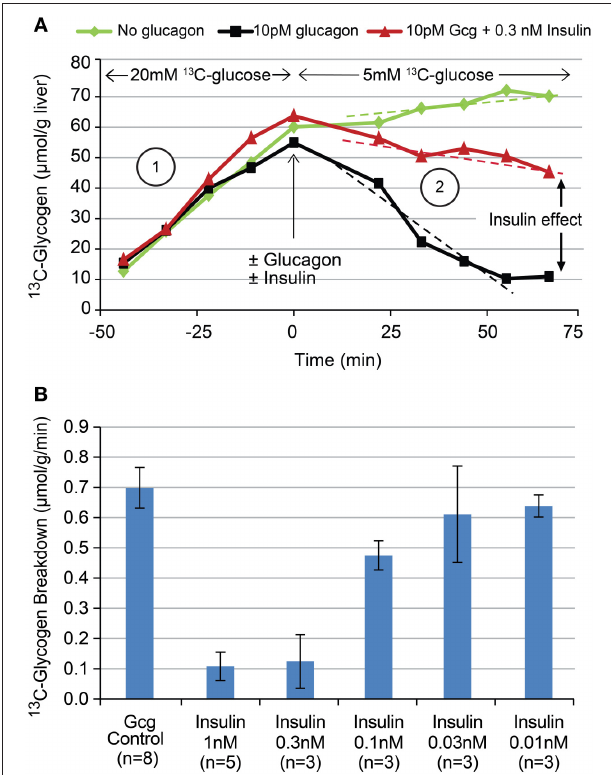
FIGURE 5 | Time courses (A) of 13 C-glycogen from three sample individual studies showing the effect of changing glucose concentrations (green), the addition of 10 pM glucagon (black), and the addition of 10 pM glucagon plus 0.3 nM insulin (red). The titration (B) of insulin’s effect on glucagon stimulated glycogen breakdown using the experimental paradigm depicted in (A)